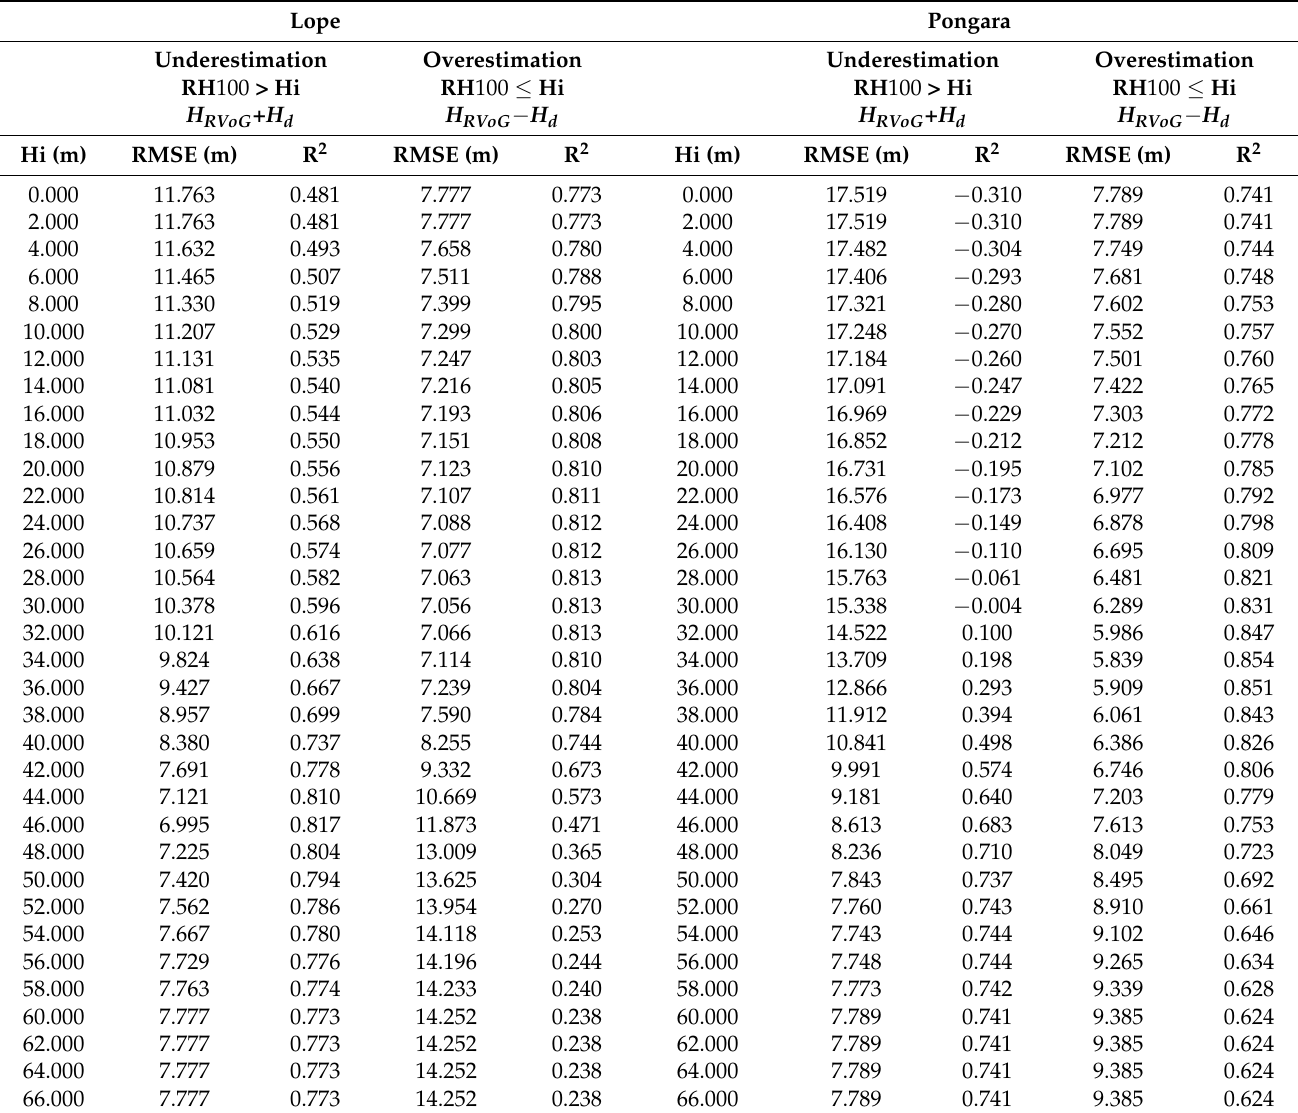
Table 3. Iteration results based on reference